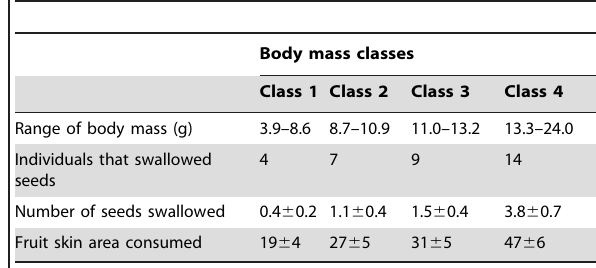
Table 2. Number of swallowed diaspores (mean 6 SE) and proportion of total fruit skin area consumed of all 10 diaspores (mean 6 SE) of A. nemorosa offered to A. rufus individuals within the four body mass classes (N =14